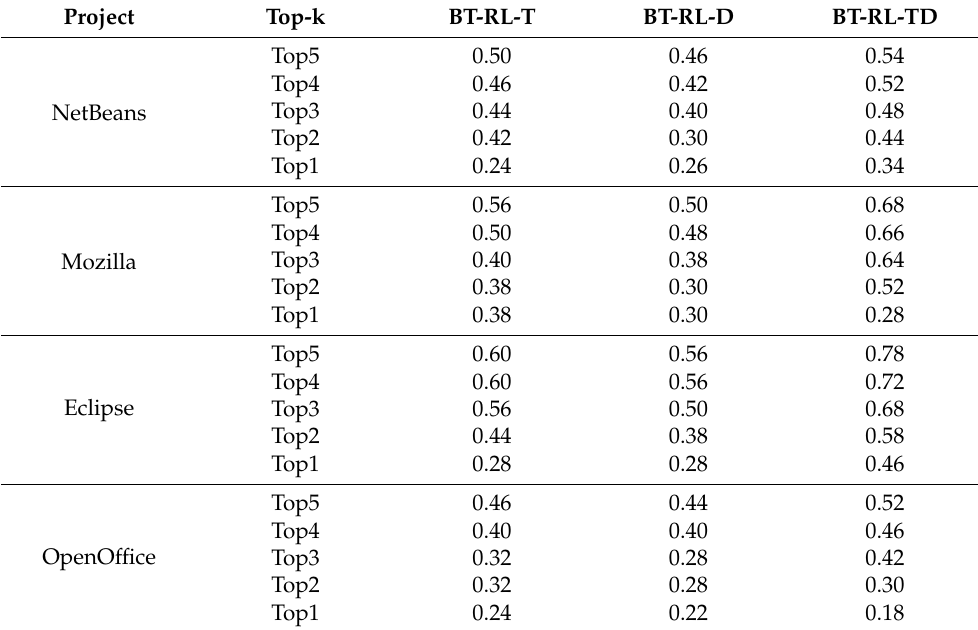
Table 7. The accuracy of BT-RL using different data fusion